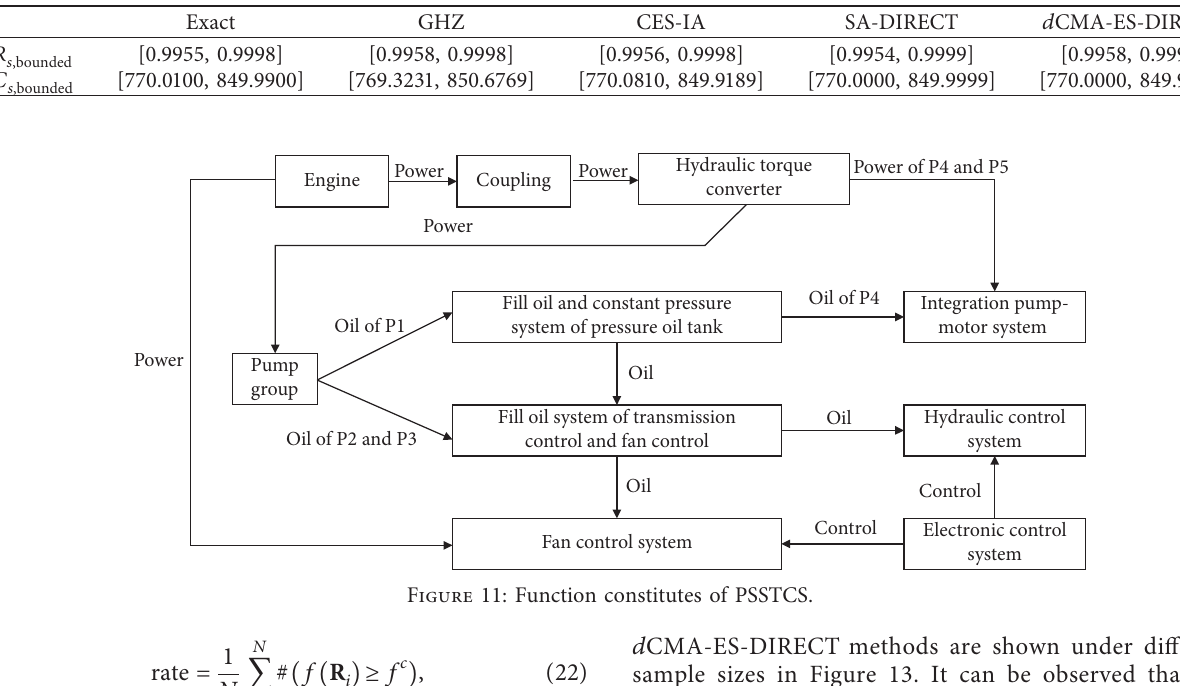
Figure 11: Function constitutes of PSSTCS.